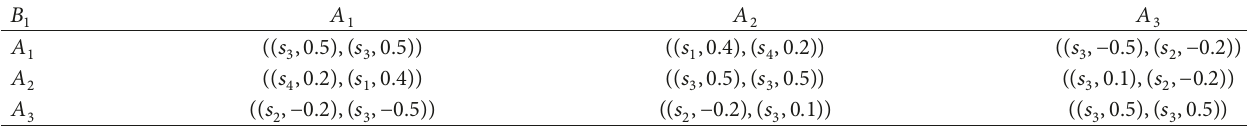
Table 3: I2TLPR of alternatives concerning the criterion 𝐶 1 .